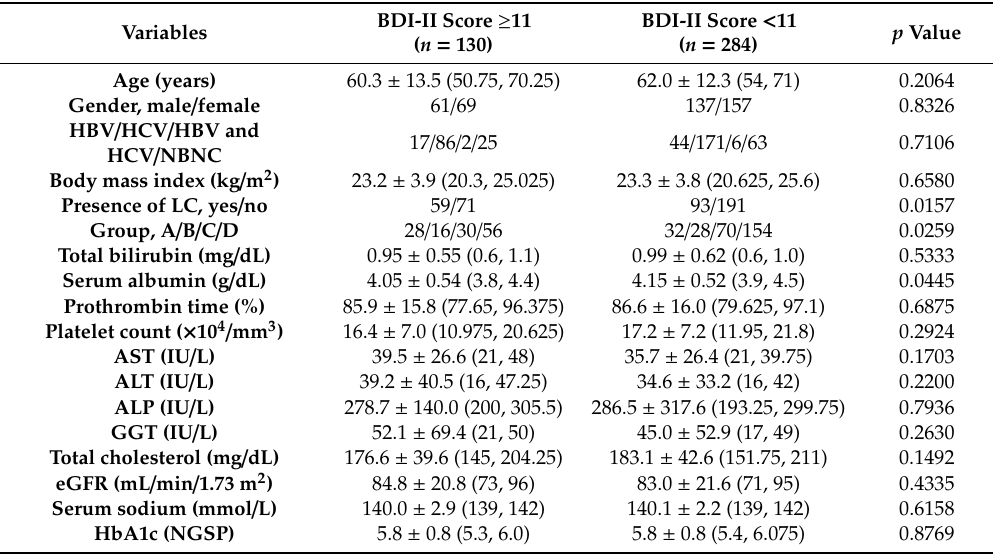
Table 3. Univariate analyses of factors linked to BDI-II score ≥ 11.